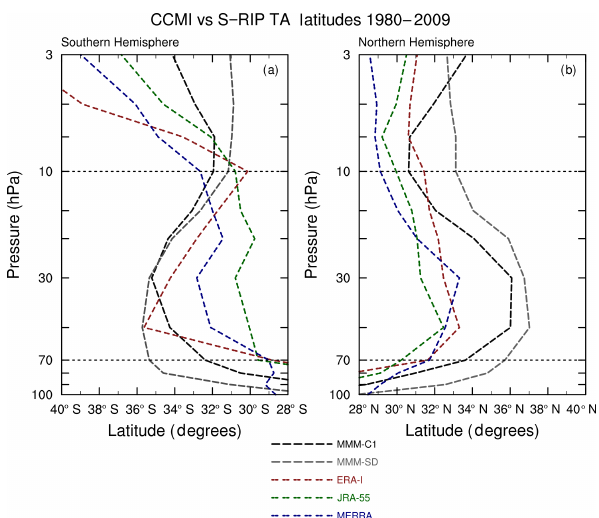
Figure 2. Vertical profiles of the climatological turnaround latitudes in the stratosphere for the MMM of the REF-C1 runs (black dashes), the MMM of the REF-C1SD runs (grey dashes), and the S-RIP re- analysis datasets (ERA-I, JRA-55, and MERRA) for the (a) South- ern Hemisphere and (b) Northern